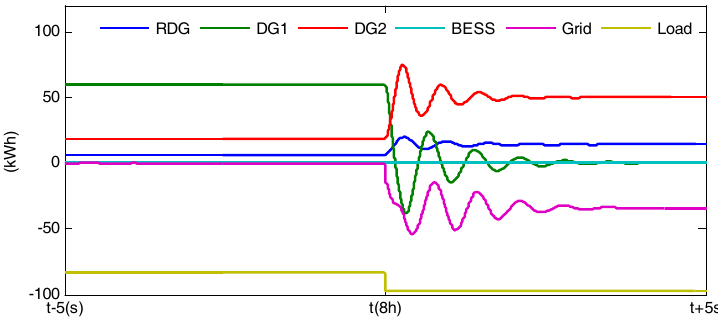
Figure 10. The response of all components in case of disconnecting DG1 at 8 h. Energies 2017 , 10 , 1484